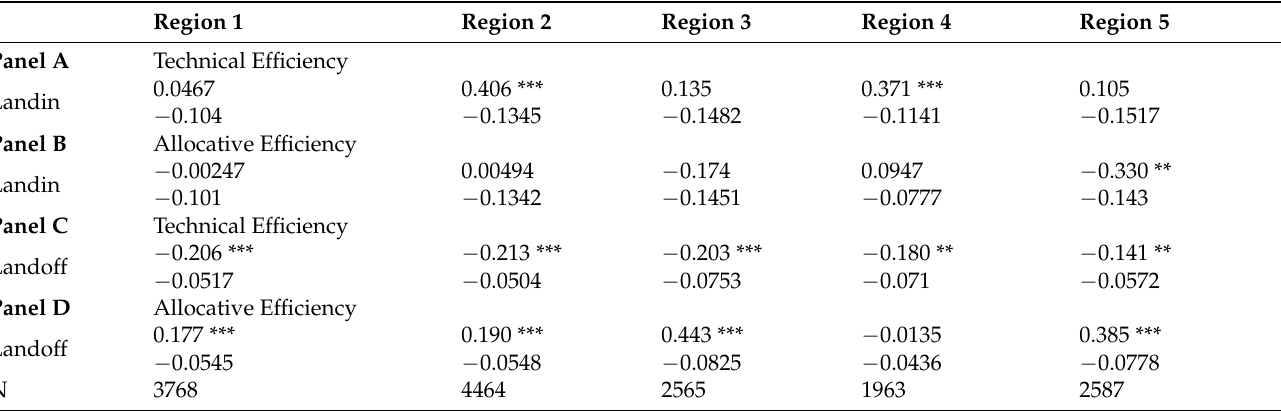
Table 8. The effect of land transfer on rural household efficiency by